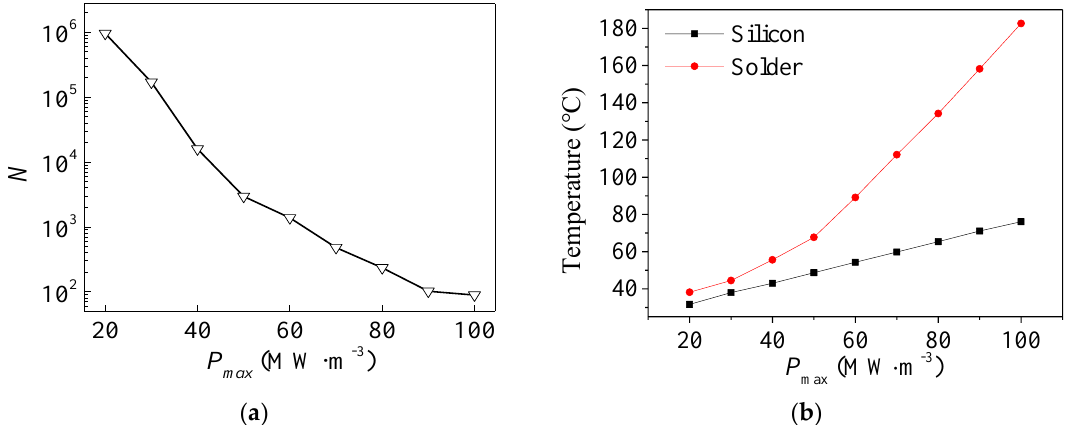
Figure 10. Effects of the maximum power density on ( a ) thermal fatigue lives of the key solder joints and ( b ) silicon temperatures and maximum of solder temperatures.